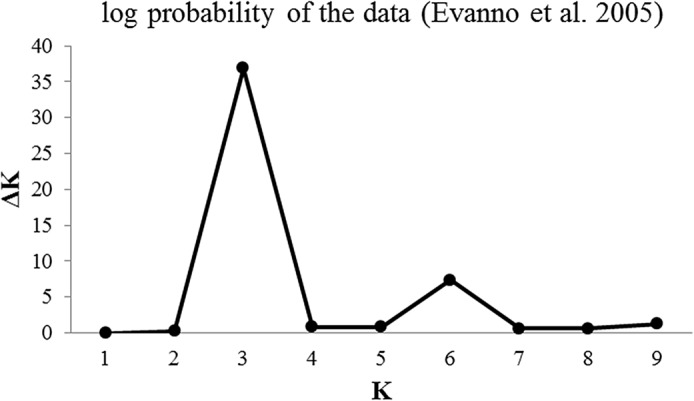
The log likelihood for each K, Ln P (D) = L (K) probability [21].